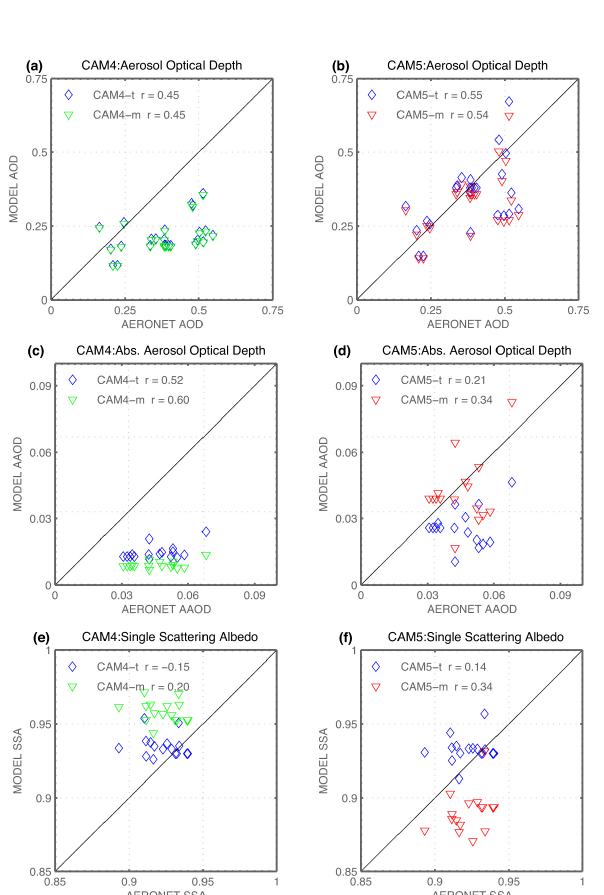
Figure 9. Annually averaged modeled aerosol optical depth (a, b) , absorbing aerosol optical depth (c, d) and single scattering albedo (e, f) at 533nm compared to annually averaged AERONET retrievals at sites where modeled AOD dust >AOD total × 0.5. CAM4 (a, c, e) and CAM5 (b, d, f) are shown.